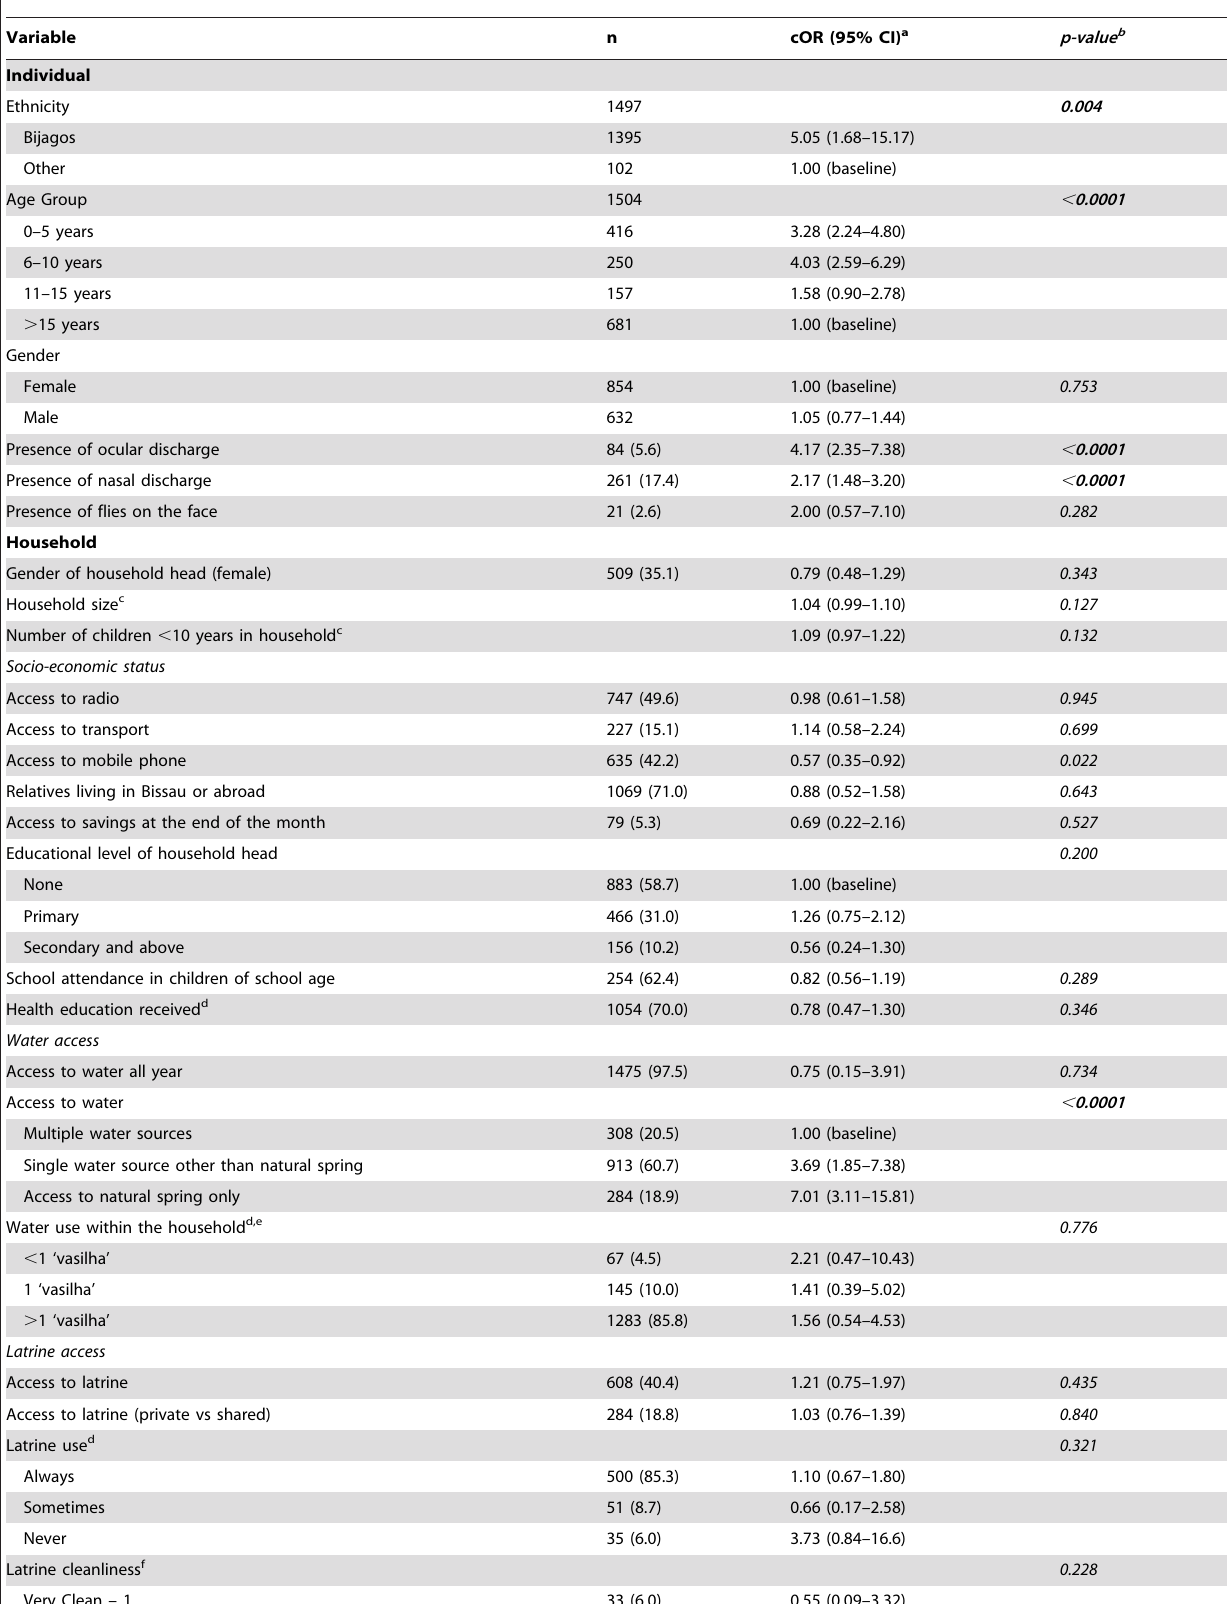
Table 5. Multilevel univariable random effects logistic regression analysis of factors associated with ocular C. trachomatis